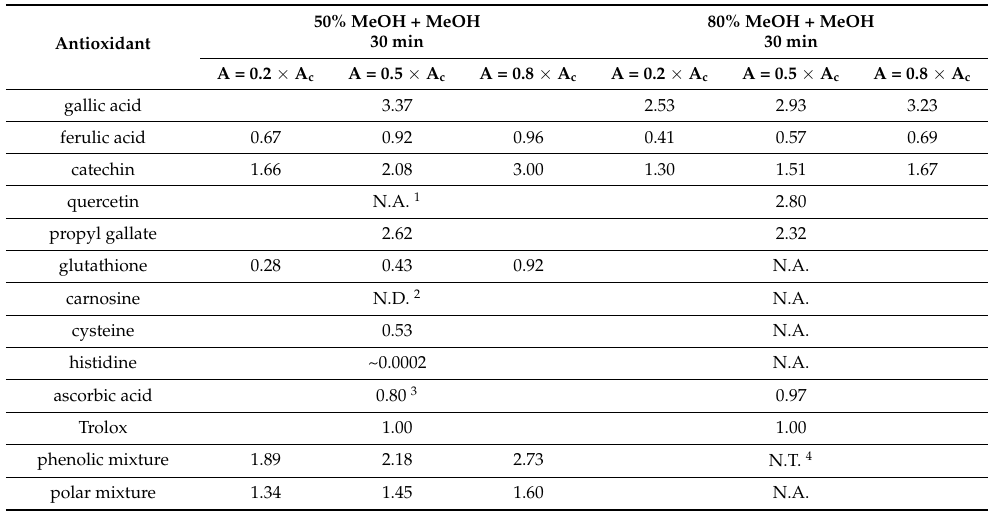
Table 12. TEAC values determined against DPPH radicals applied in aqueous methanol (radical solution in methanol) after standard reaction